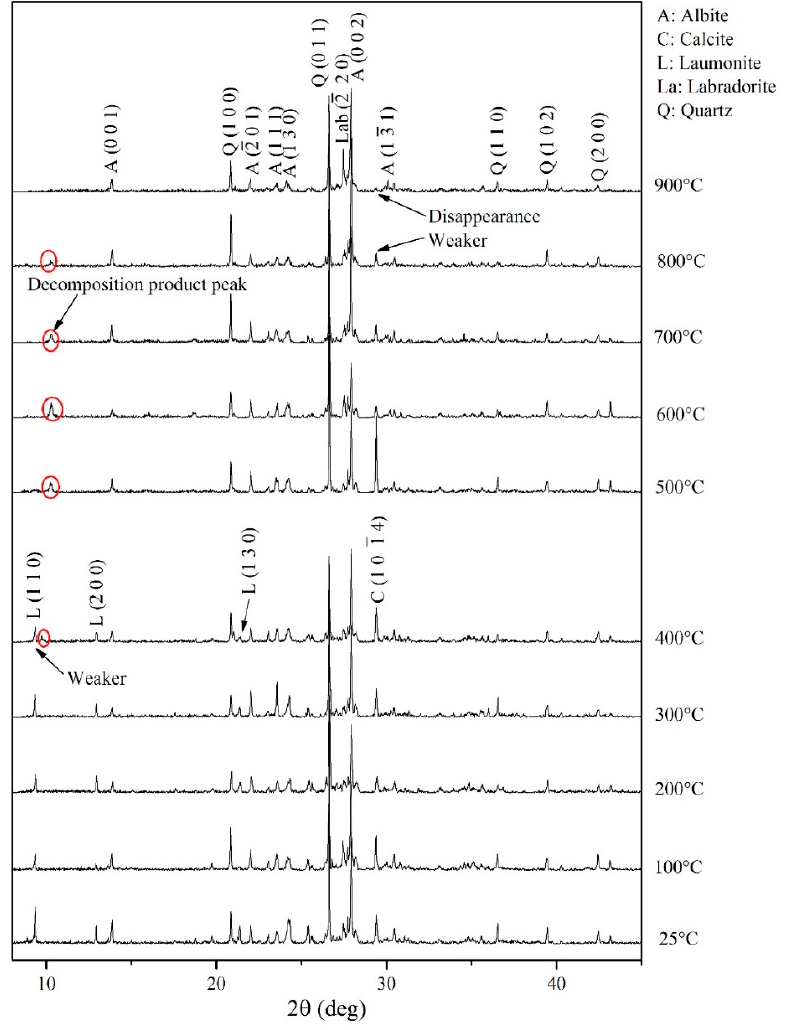
Figure 1. X-ray diffraction (XRD) patterns with different heating temperatures from 25 °C to 900 °C.